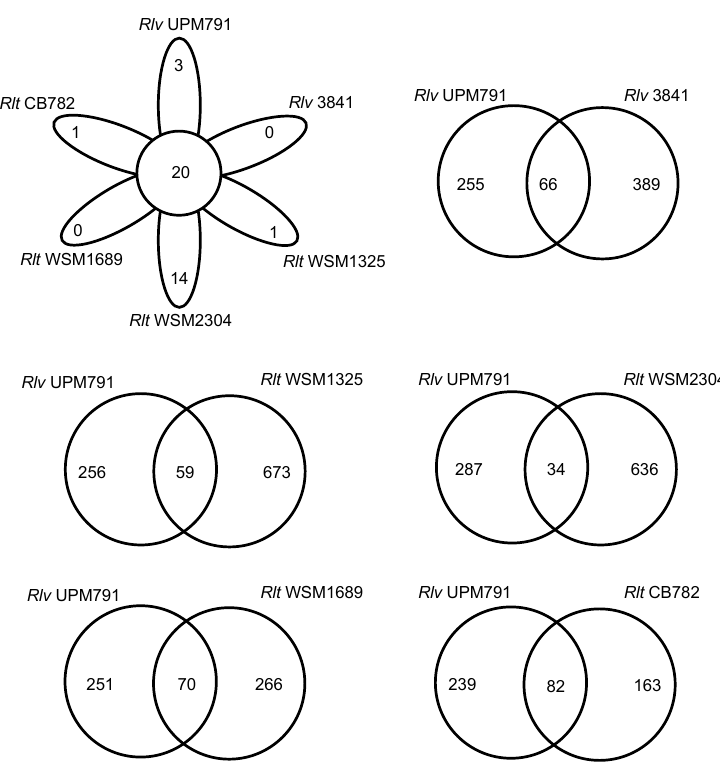
Figure 5. Venn diagram showing the number of protein families shared among the symbiotic plasmids from strains Rlv UPM791, Rlv 3841, Rlt WSM2304, Rlt WSM1325, Rlt WSM1689, and Rlt CB782, and also between that of Rlv UPM791 and those of each of the other strains.